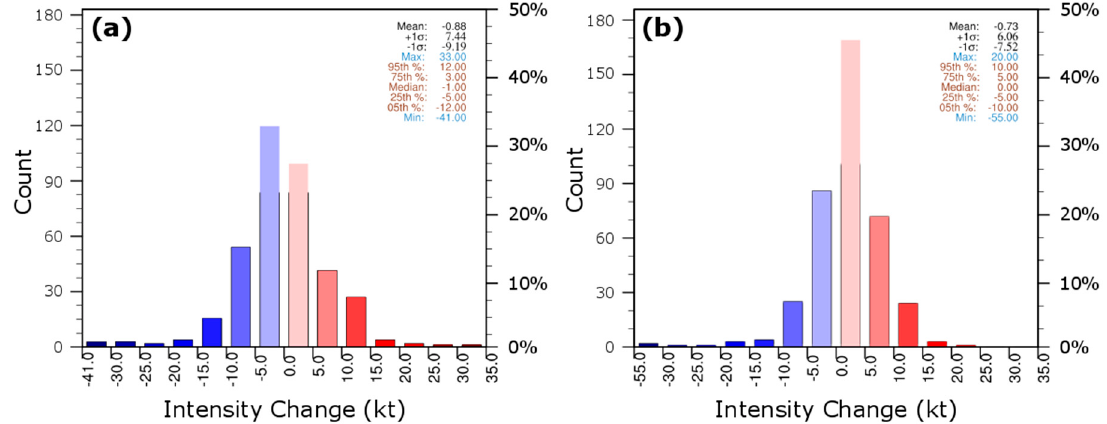
Figure 5. Histograms of 6 h intensity change for: ( a ) HWRF-B forecasts at 72 h lead times and ( b ) best track data at corresponding valid times. Intensity change is binned every 5 kt, except for the first bin, which extends from − 30 kt to the minimum intensity change: ( a ) − 41 kt and ( b ) − 55 kt. The statistics for the distributions are provided in the upper right of each panel.